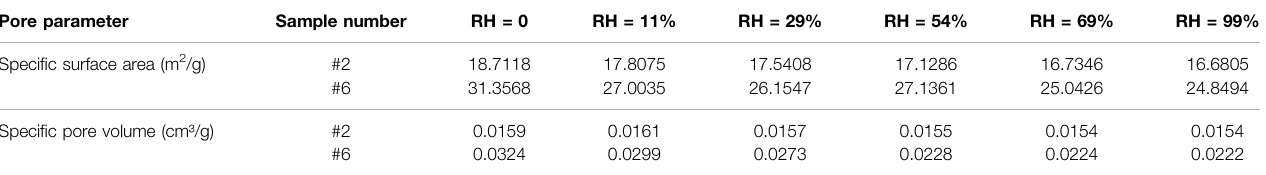
TABLE 5 | Comparison of speci fi c surface area and speci fi c pore volume of samples #2 and #6 with different